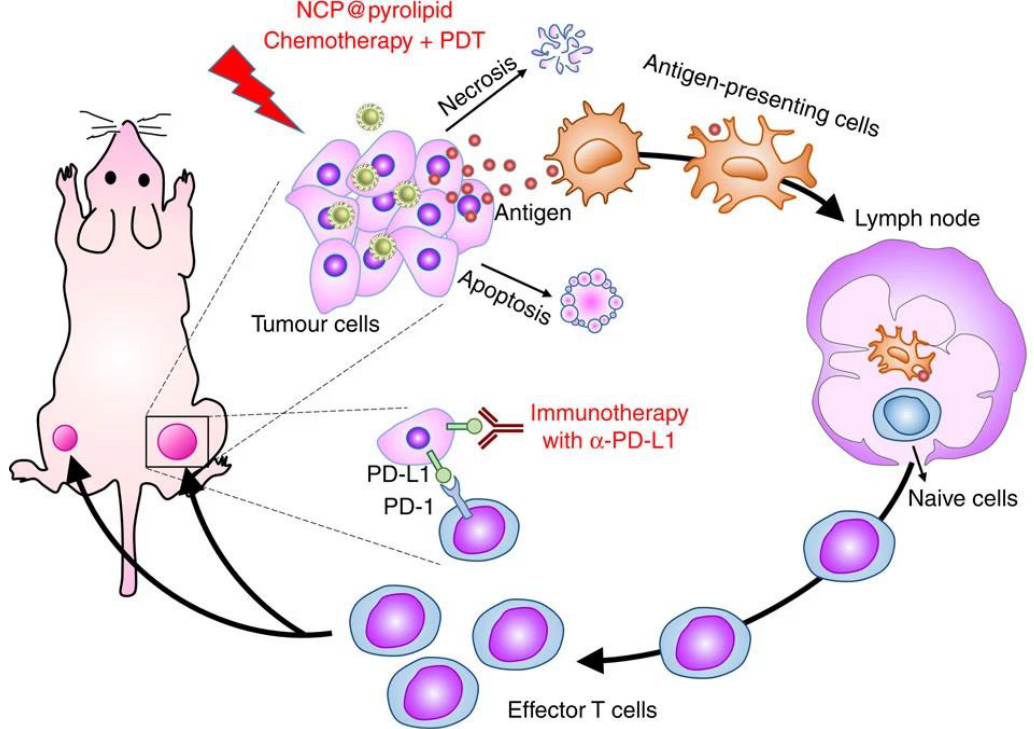
Figure 4. Schematic of the combined action (Chemotherapy + PDT) of nanostructured coordination polymers (NCP) @pyrolipid able to induce immunogenic cell death and an inflammatory environment at the primary tumor site, which leads to the release of tumor-associated antigens (TAAs). The result of this action is not only tumor eradication in the primary sites but also a systemic antitumor immune response to reject distant tumors. The figure is reproduced from Reference [82] with the permission from Springer Nature.